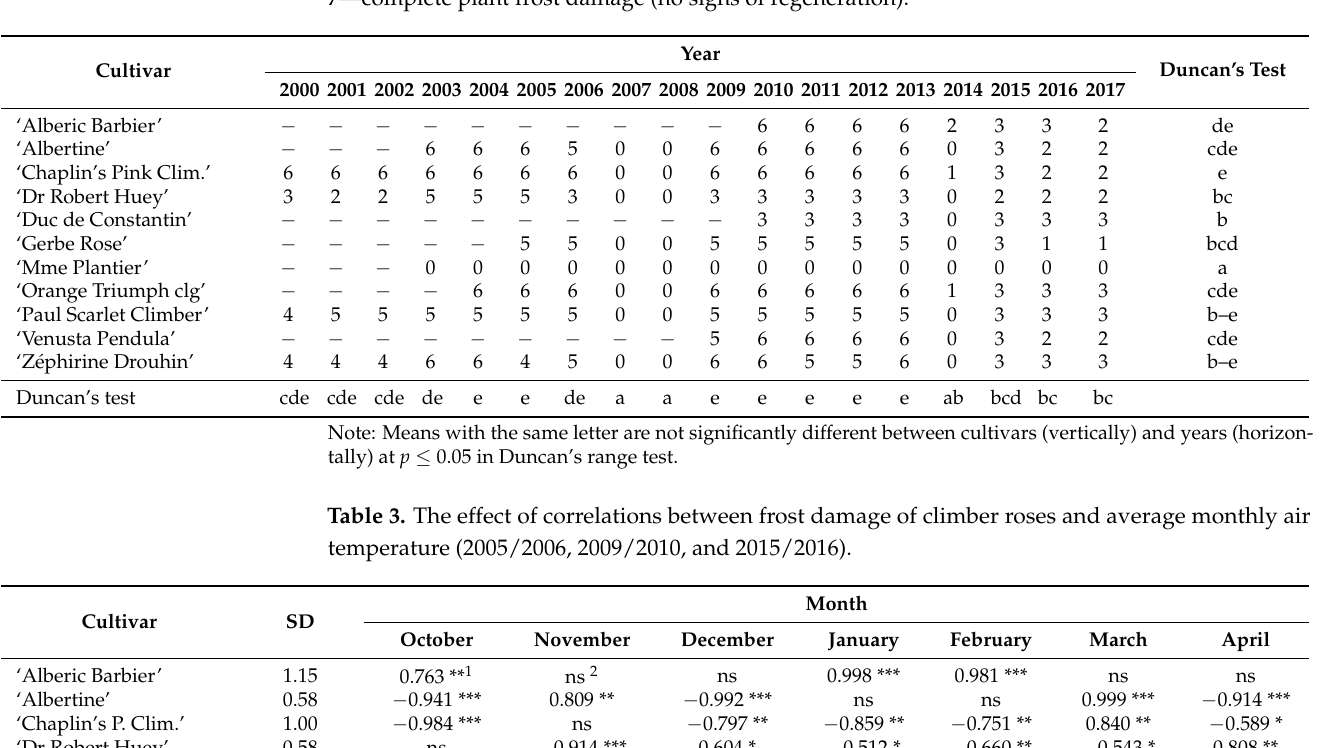
Table 2. Frost damage of climber roses evaluated in valuation scale. where: 0—undamaged plants; 1—darkened vascular bundles on shoots, but buds still develop; 2—frost-damaged leaf buds; 3— frost-damaged one-year-old shoot tips; 4—frost-damaged one-year-old shoots or only their living bases; 5—frost-damaged 2-year-old and older shoots; 6—frost-damaged shoots to the ground level; 7—complete plant frost damage (no signs of regeneration).